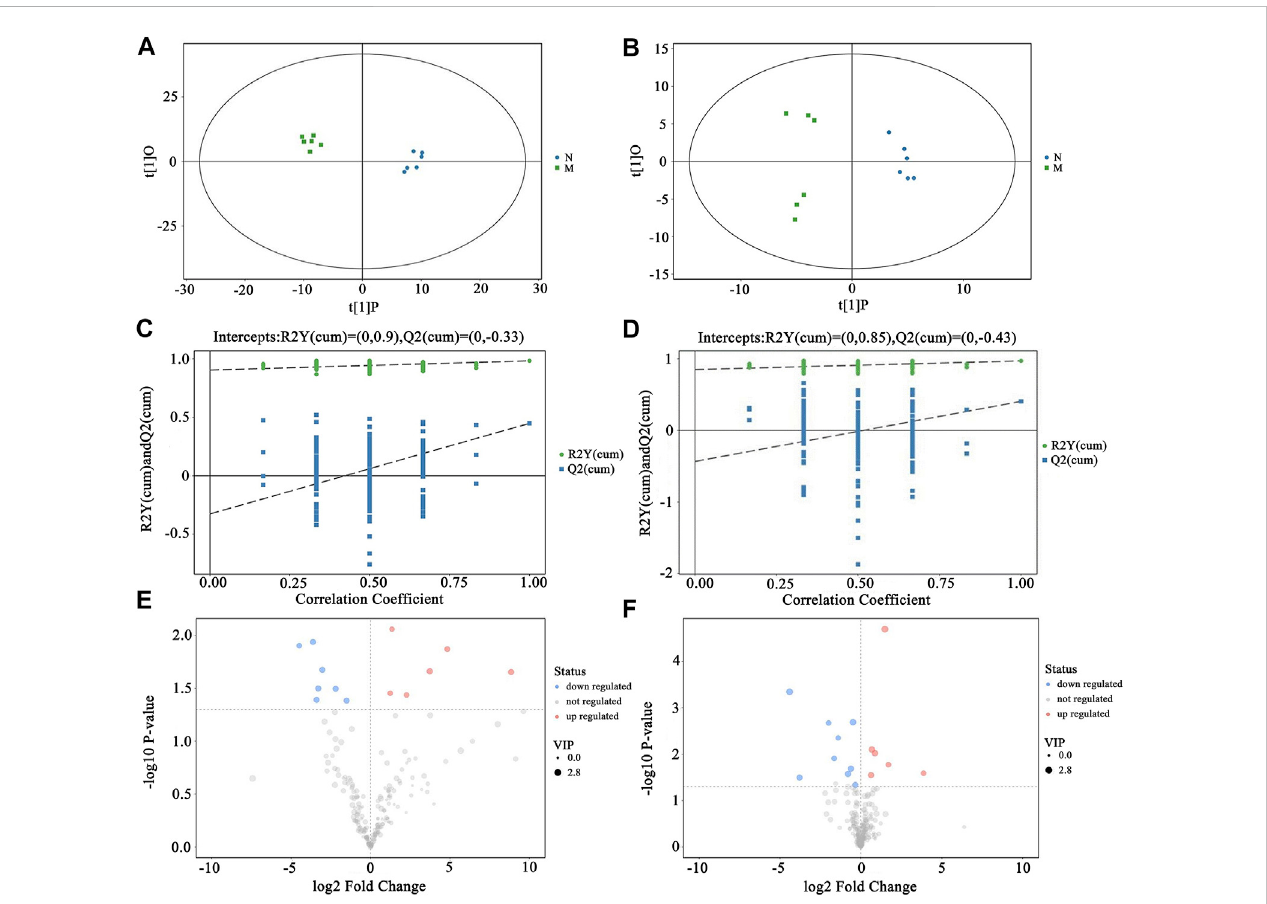
FIGURE 5 Screeningofbiomarkersinratswithkidney-yangde fi ciency.NVS . M, (A) UrineOPLS-DAscoresplots, (B) PlasmaOPLS-DAscoresplots, (C) UrineOPLS- DA permutation test, (D) Plasma OPLS-DA permutation test, (E) Urine Volcano plot, (F) Plasma Volcano plot. Red represents upregulation of differential metabolites. Blue represents downregulation of differential metabolites. Gray represents metabolites with no statistical